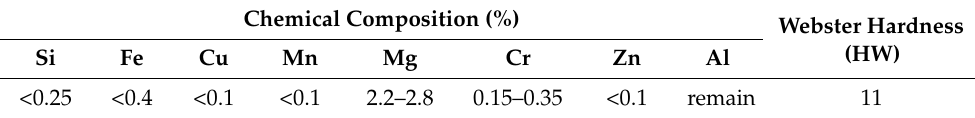
Figure 9. Experimental validation of the force fluctuation characteristics: ( a ) experimental environment and ( b ) description of the milling process and the fast estimation method. Table 4. Chemical composition and hardness of the A5052 aluminum alloy. Chemical Composition (%)